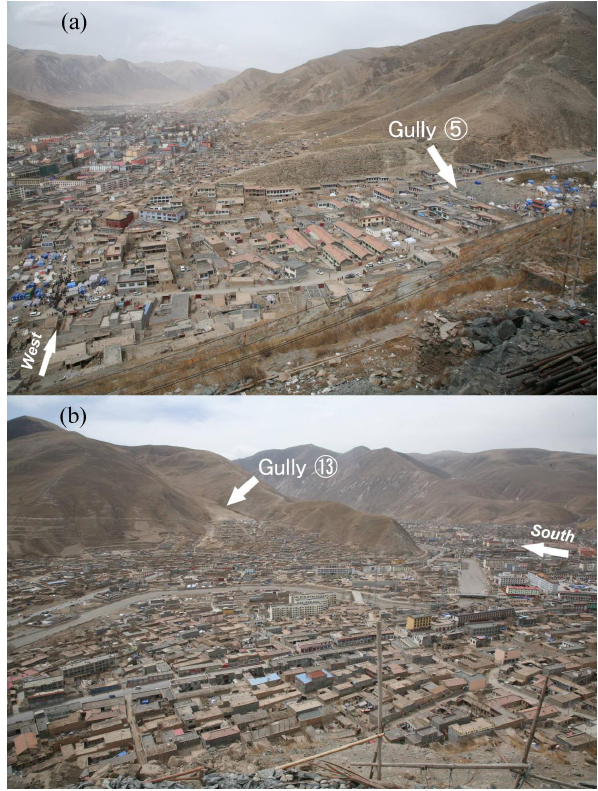
Fig. 3. Settlement area in Jiegu township. Photos were taken after YE at the site indicated in Fig. 2. (a) Look west; (b) Look south. It is shown that the outlets of gully 5 and gully 13 are heavily populated. Note: buildings in the east part of Jiegu township did not suffer from severe damage in YE (photos courtesy of Dr. Yueping Yin).